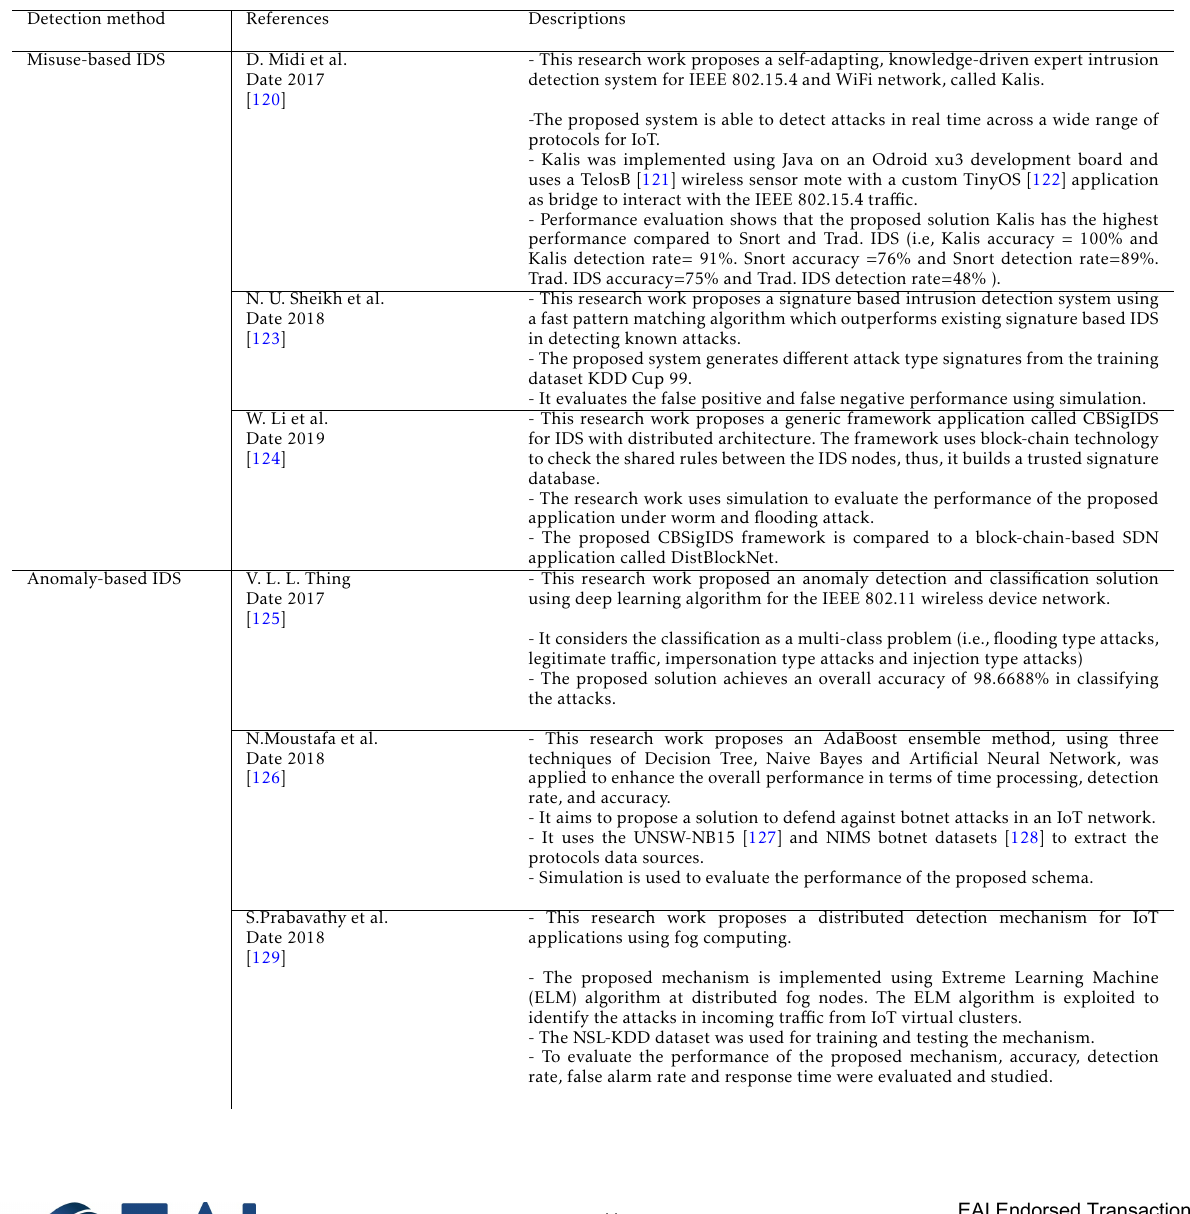
Figure 2. IDS categories Table 2. Summary of IDS for IoT in recent